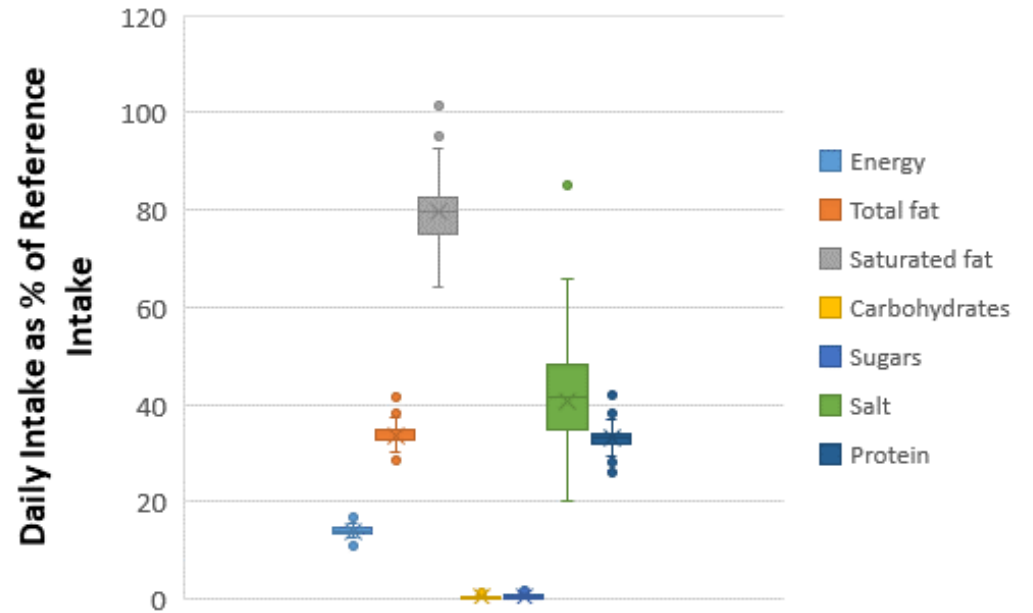
Figure 6. Daily intake per capita as a percentage of European daily reference intakes (RIs), for the 95th percentile of the daily consumption of prepacked feta cheese marketed in the Greek Market.